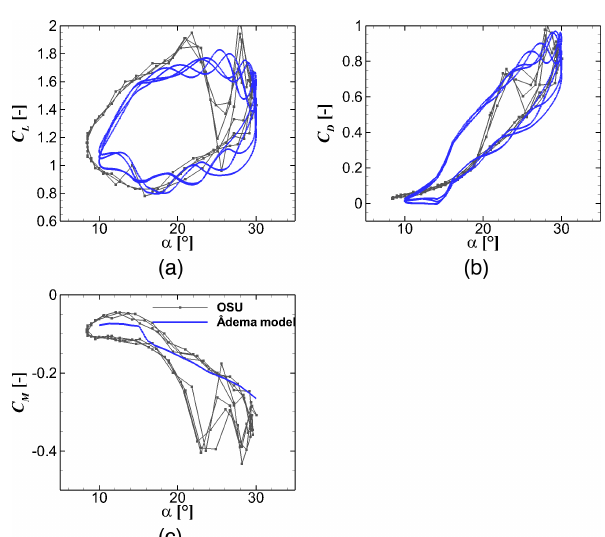
Table 4. Critical angle of attack ( α CRIT n ) applied for the Leishman– Beddoes and IAG models.